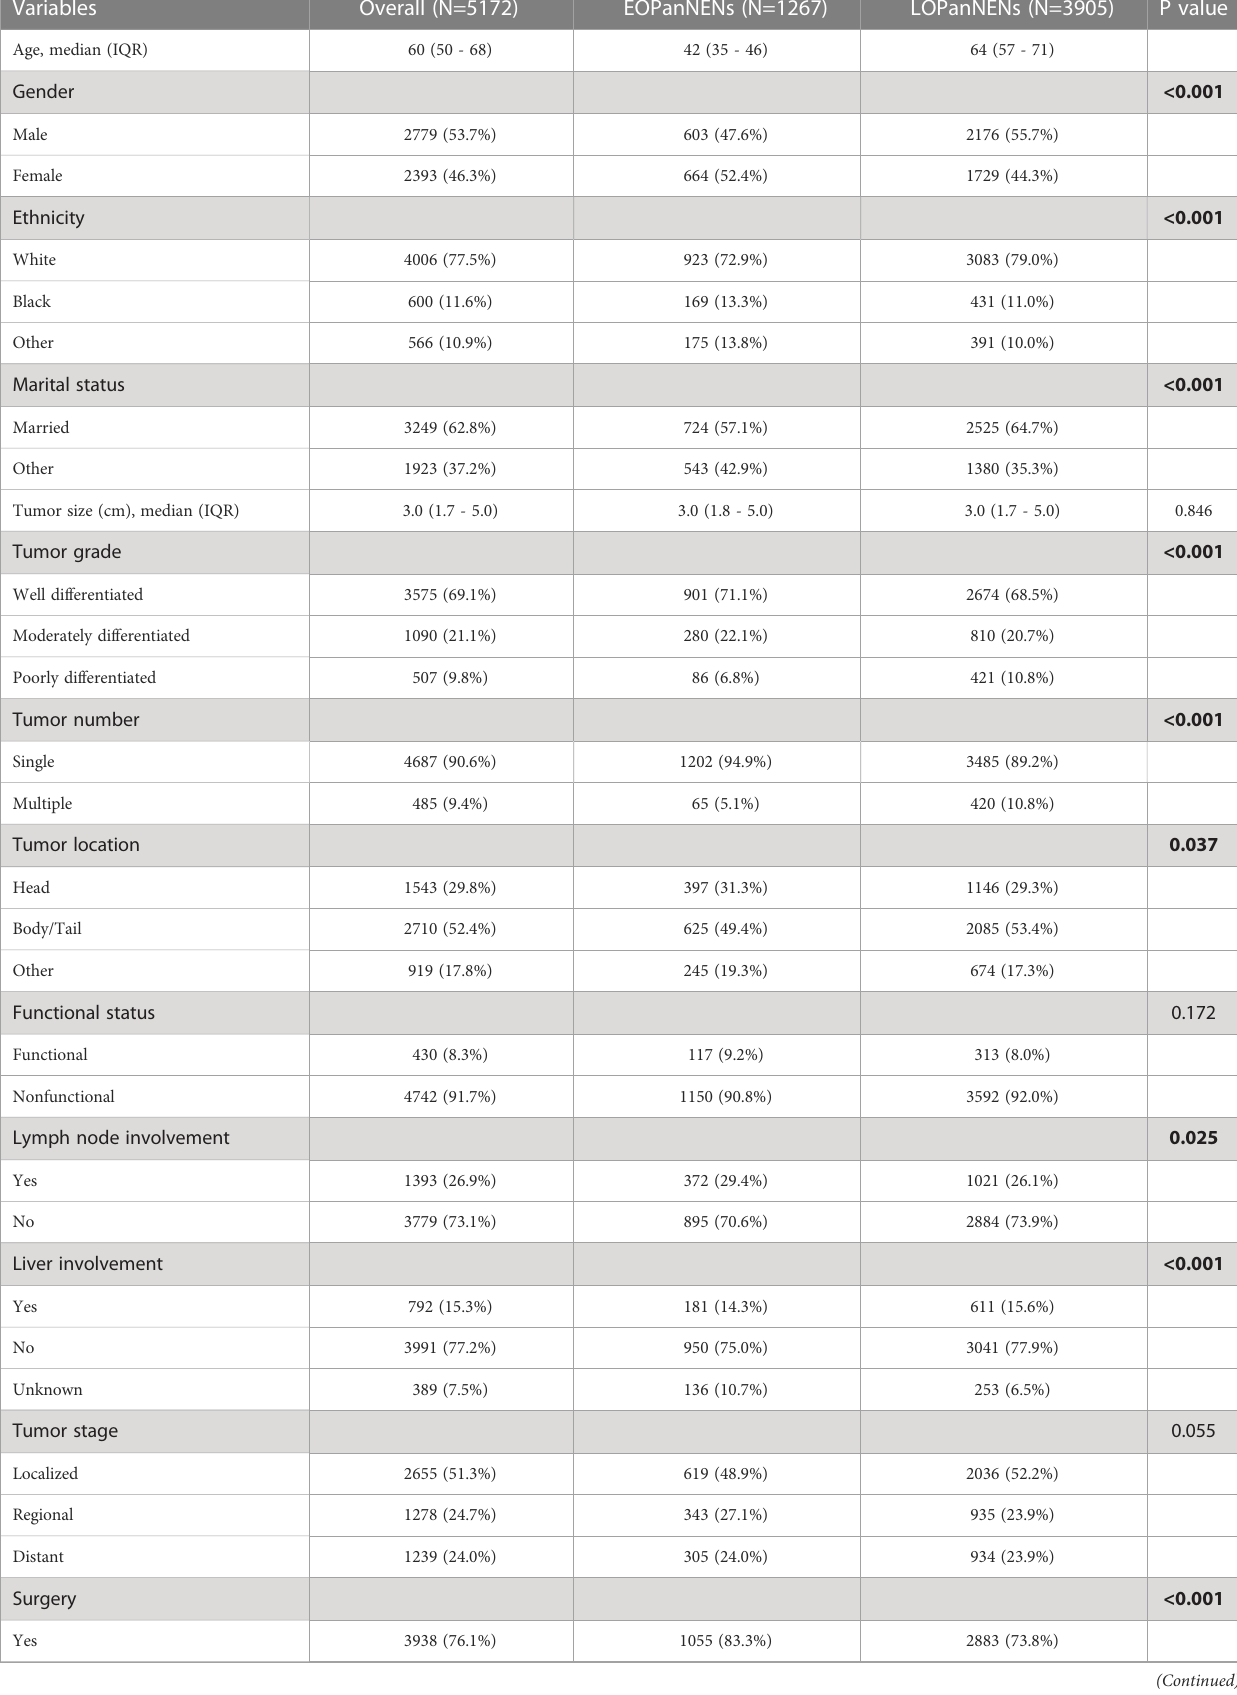
TABLE 1 SEER cohort demographics, pathologic characteristics, and survival